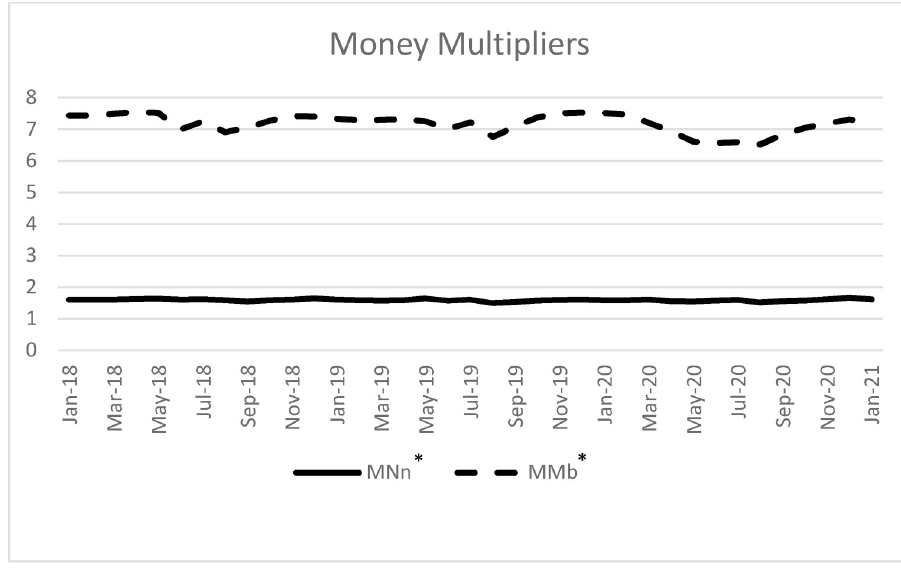
Fig 1. Narrow money multiplier ( MM n ) and broad money multiplier( MM b ). � We use total currency issued by the central bank as a measure of base money to match the exposition presented here.